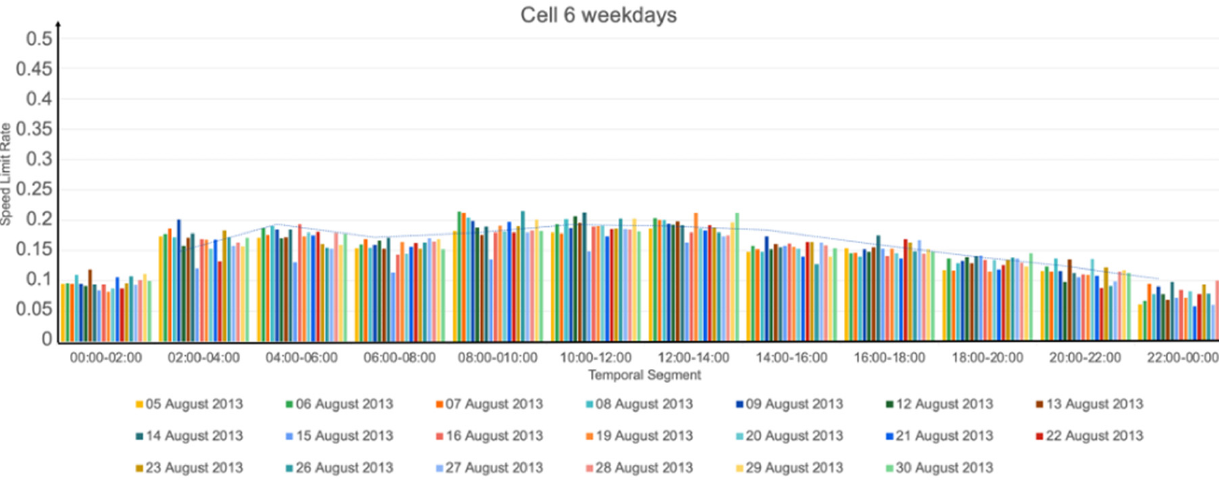
Figure A4. Results for the weekdays, cell 6 with MaxSpeed = 30